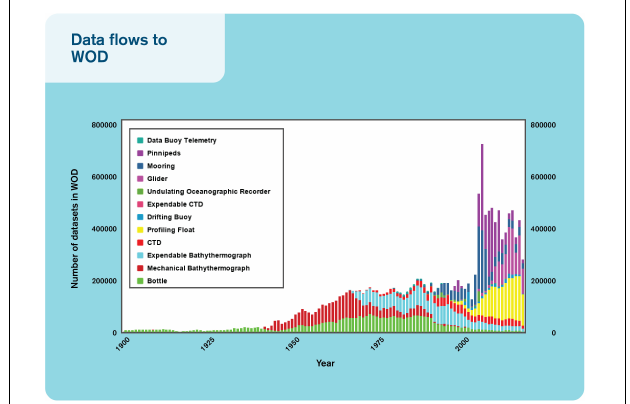
FIGURE 1 | The number of datasets flowing to the World Ocean Database over the past